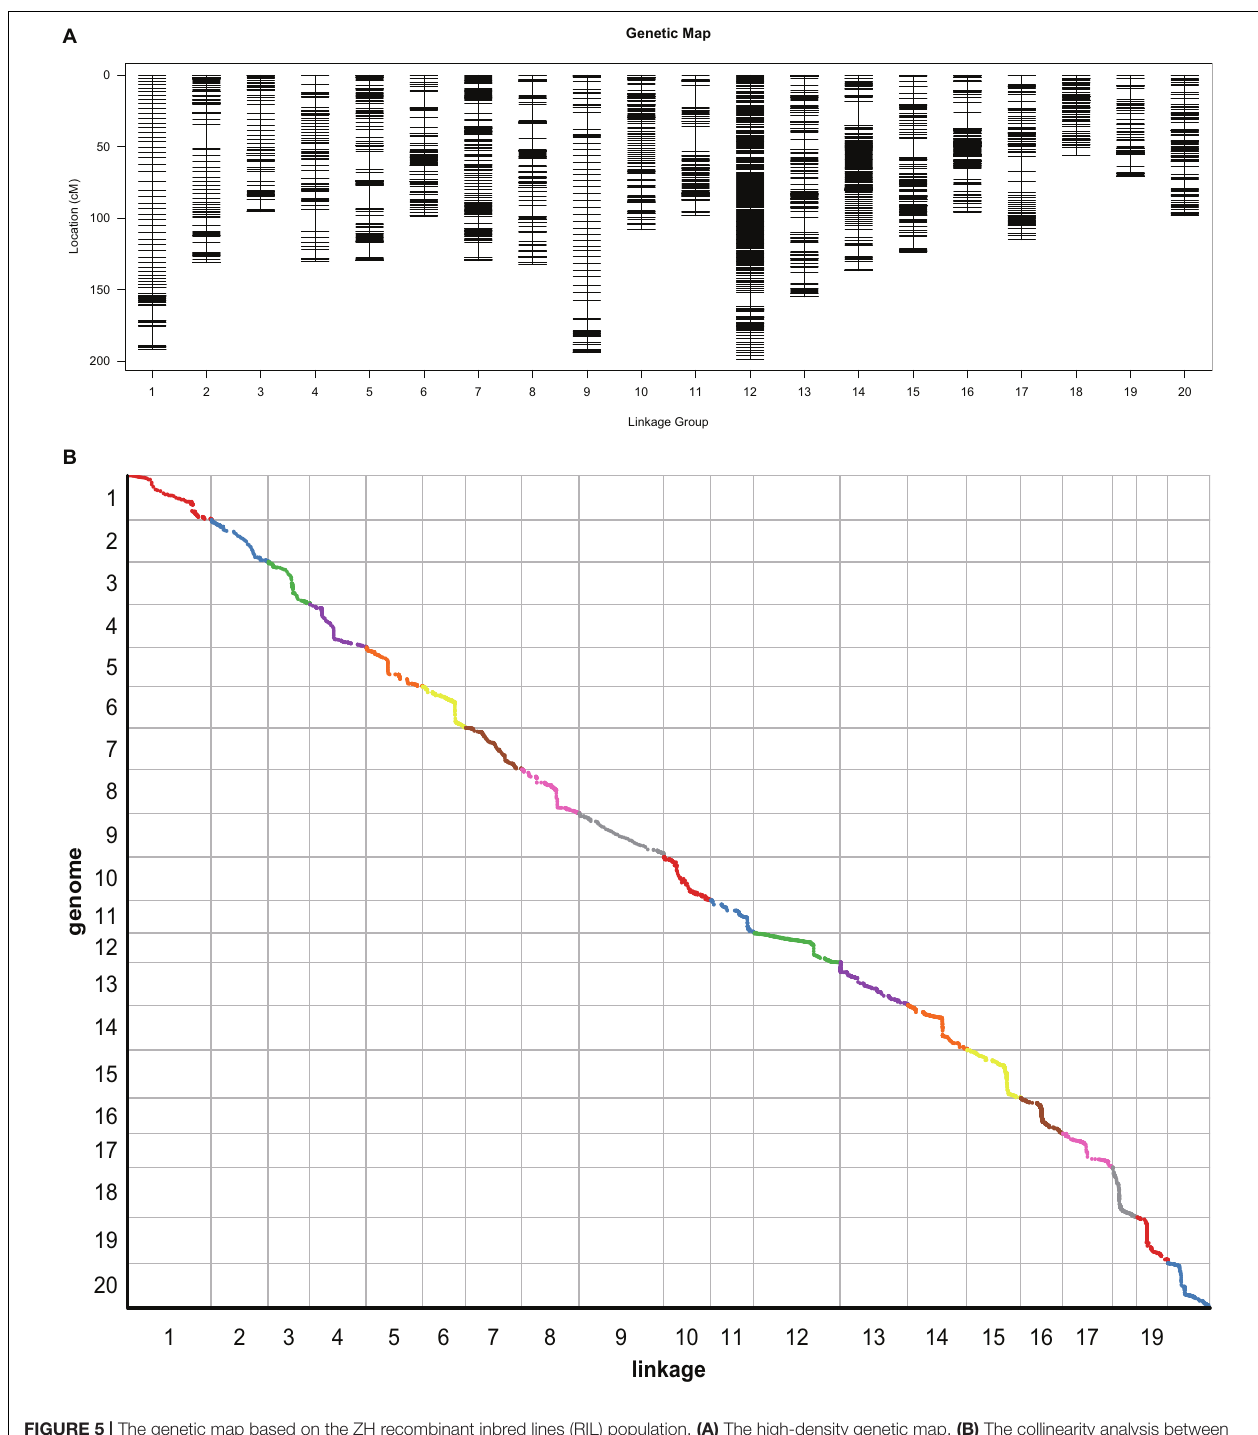
previous research data and used a higher quality genetic